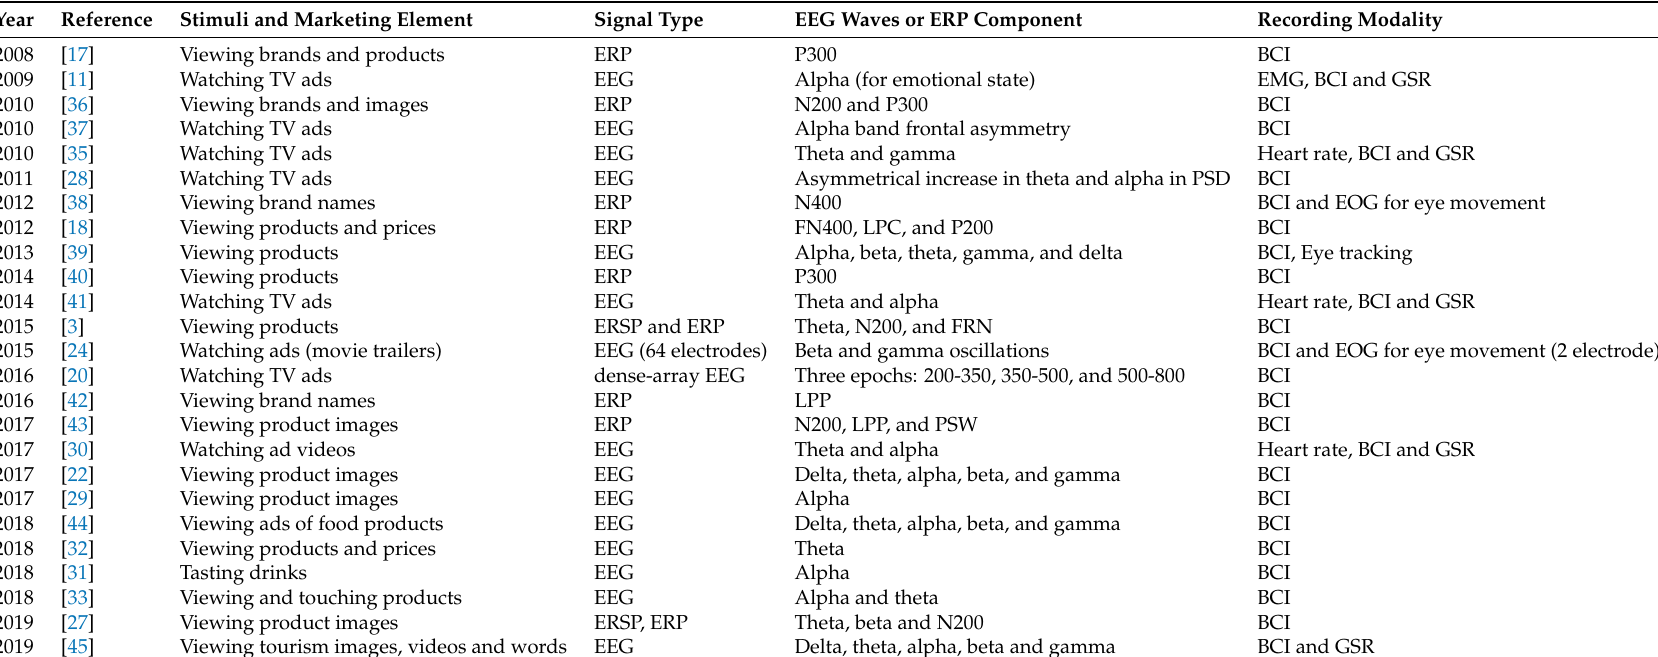
Table 4. EEG-based neuromarketing